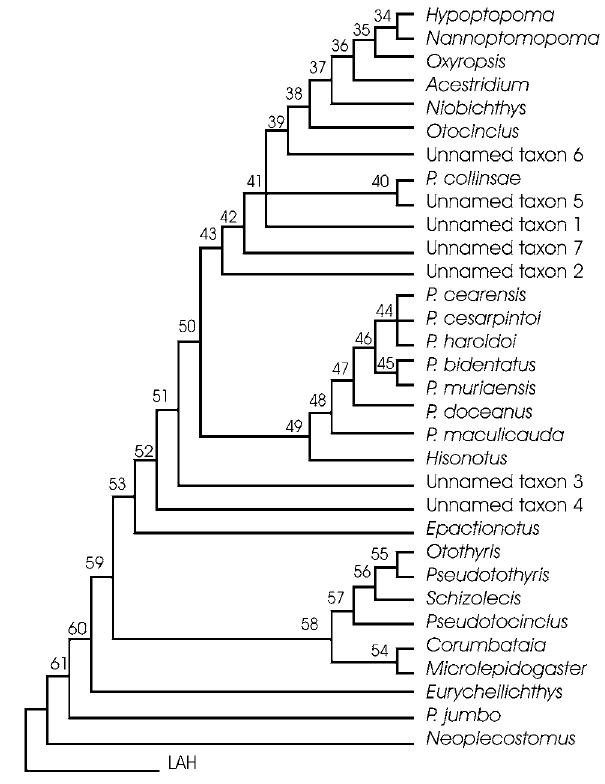
Fig. 4. Most parsimonious cladogram selected by successive weighting. Character-state changes optimized by